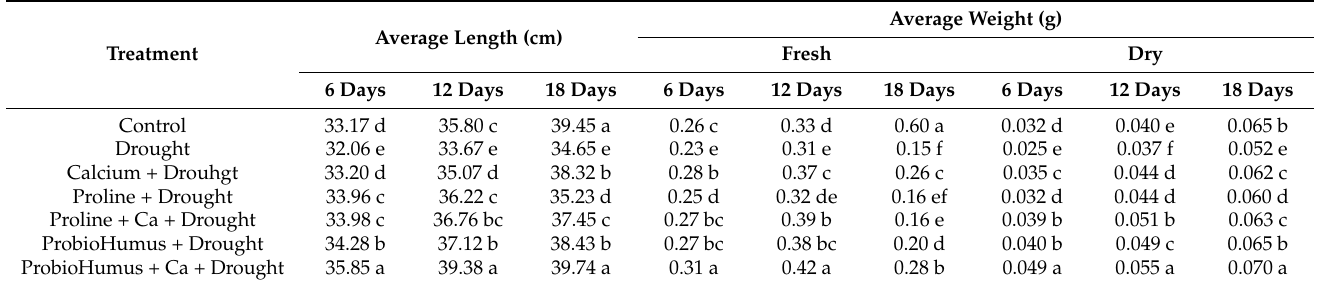
Table 1. Effect of stress-protecting compounds on morphometric parameters of winter wheat seedlings (per plant).